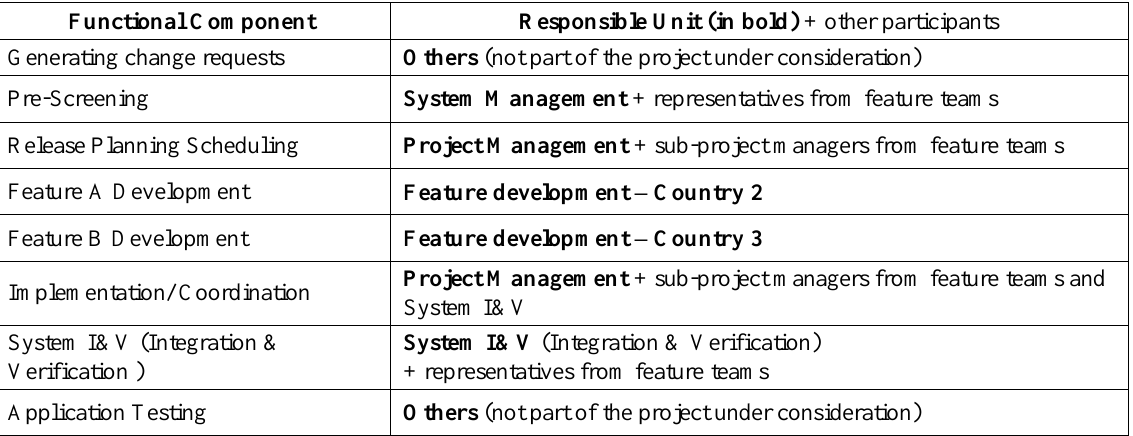
Table 1. Mapping of functional components and team responsibility